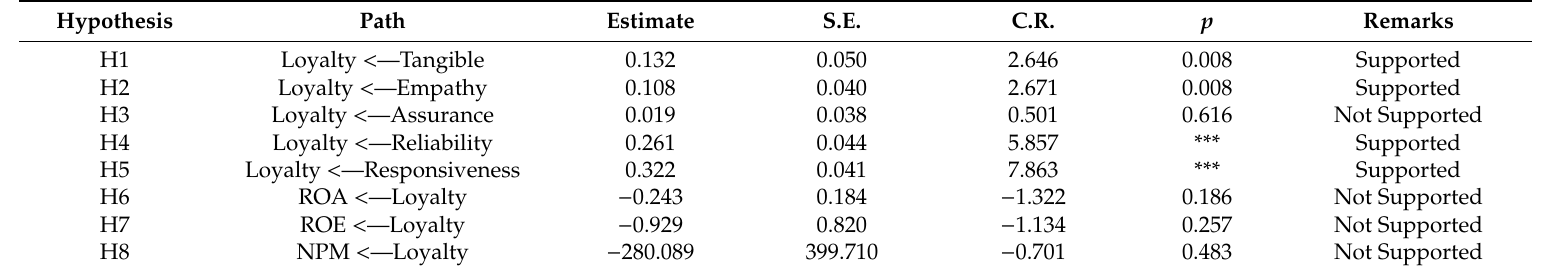
Table 7. Regression analysis and hypotheses